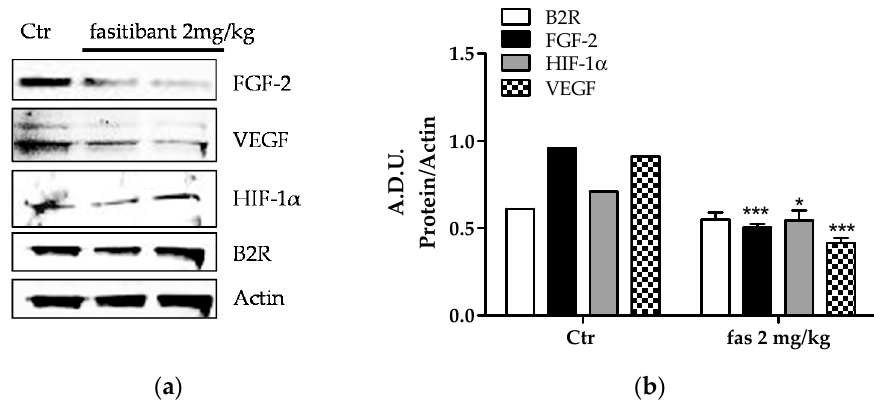
in retinal microvessels (Figure 5a). It also reduced, at a lesser extent, hypoxia inducible factor (HIF)-